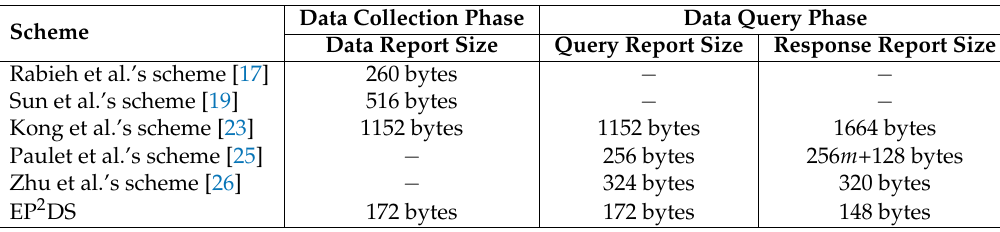
Table 5. Comparison of the communication